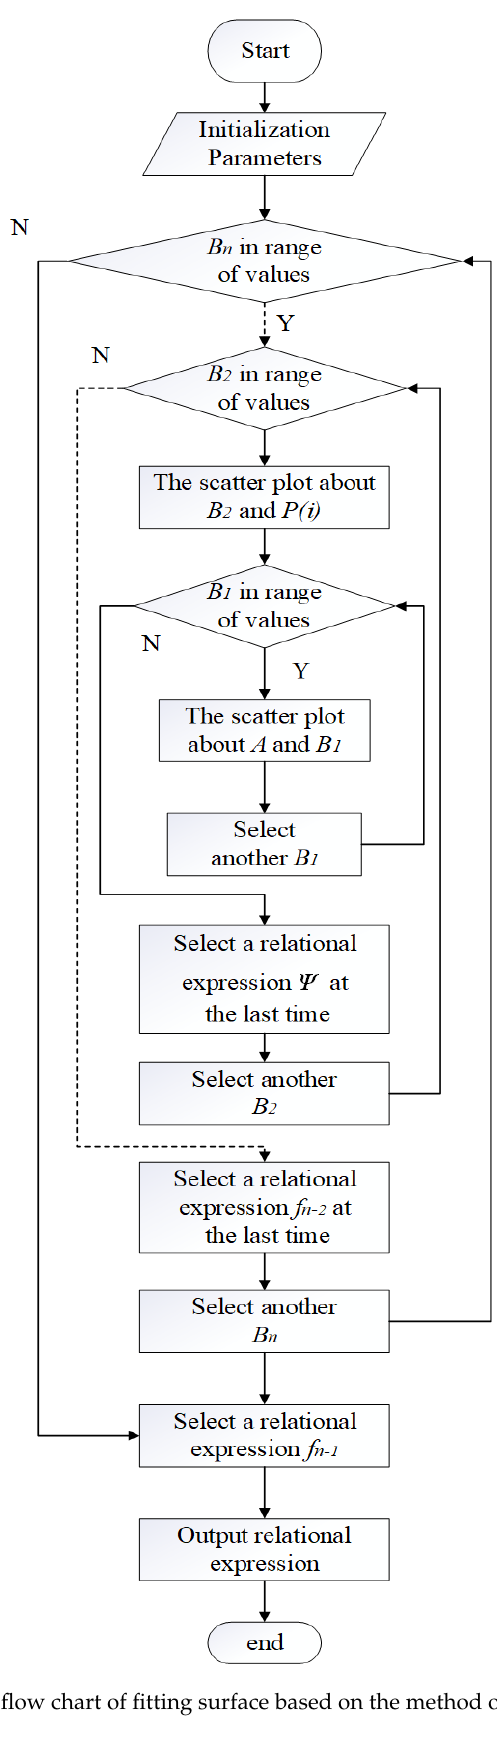
Figure 5. The flow chart of fitting surface based on the method of curve fitting.